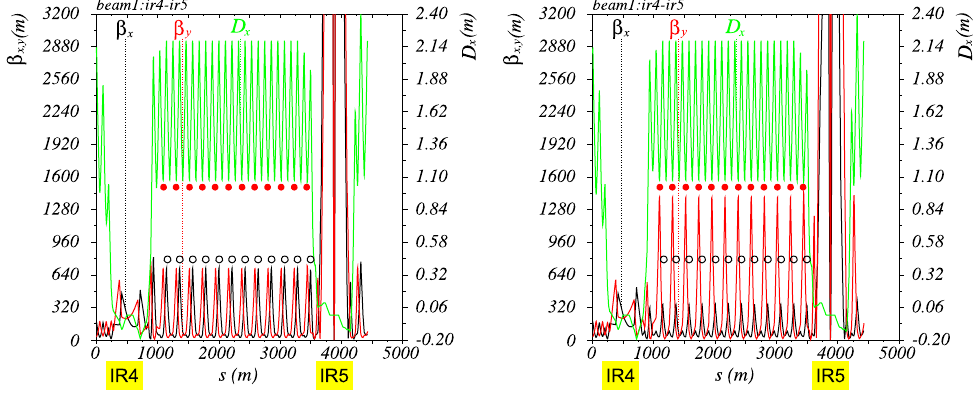
FIG. 4. Modification of the (cid:1) functions in the arc 45 of the LHC during the telescopic squeeze, starting from a round presqueezed ¼ 40 cm at IP5 and specific phasing properties (a), and reaching two possible collision optics, either round with optics with (cid:1) (cid:1) 0 ~ (cid:1) (cid:1) ~ (cid:1) (cid:1) ~ (cid:1) (cid:1) x;y ¼ 10 cm (b) or flat with x ¼ 20 cm and y ¼ 5 cm (c). The telescopic squeeze is achieved by acting only on the matching quadrupoles of IR4 on the left (and IR6 on the right), as soon as specific betatron phase advances have been achieved for the presqueezed optics (see Sec. II B 1). The peak (cid:1) functions in the arcs are increasing in proportion to the reduction of (cid:1) (cid:1) , i.e. by a factor of 4 in both planes for case (b), and by the factors 2 and 8 in the horizontal and vertical planes, respectively, for case (c). The empty and full markers indicate the location of the focusing and defocusing sextupoles, respectively, which participate to the chromatic correction of the LHC inner triplet. These sextupoles can be operated at quasiconstant settings during the telescopic squeeze with the (cid:1) functions = ~ (cid:1) (cid:1) at their respective location (see Sec. II B increasing proportionally with (cid:1) (cid:1) 0